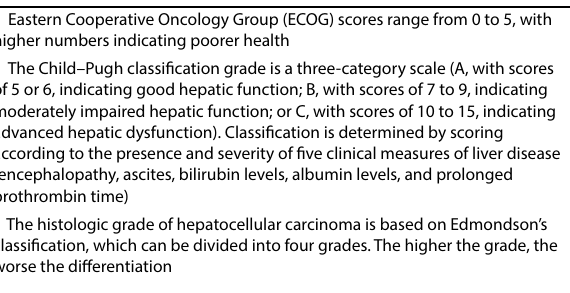
Table 1 Patient characteristics at